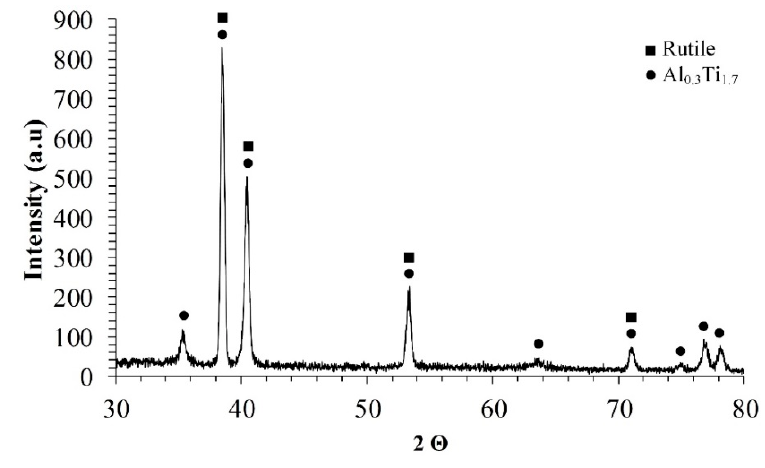
Figure 4. X-ray diffraction pattern of the alloy Ti-6Al-4V surfaces after MAO treatment.